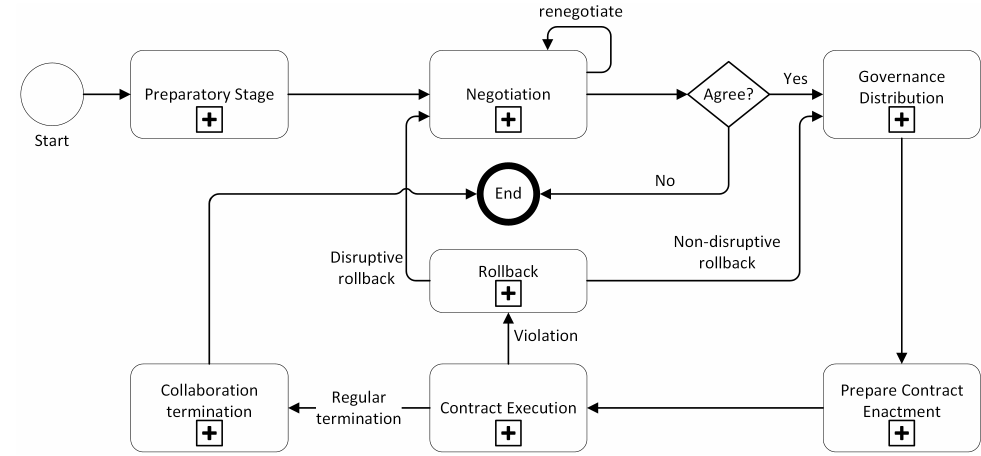
Figure 2. Conceptual lifecycle for M2X business enactments–Based on